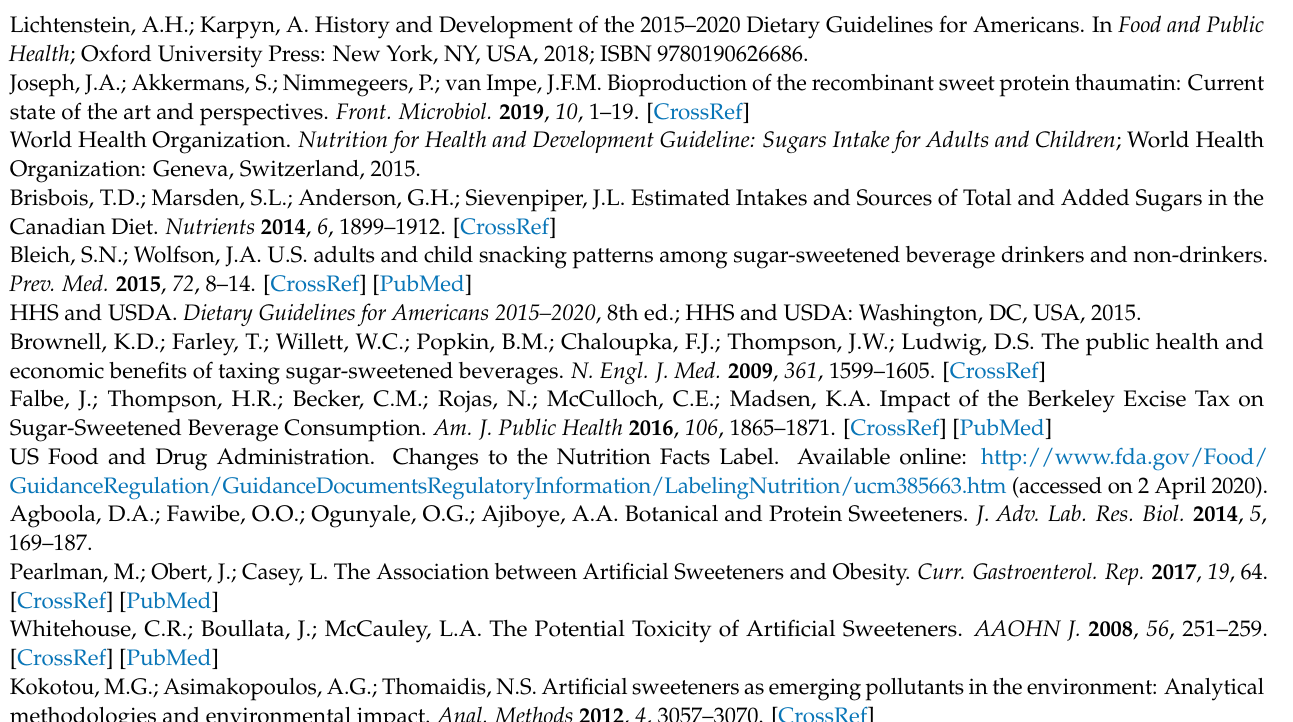
Table S8: Transient production facility detailed annual labor cost, Table S9: Transgenic production facilities dependent costs estimation parameters, Table S10: Transient production facilities dependent costs estimation